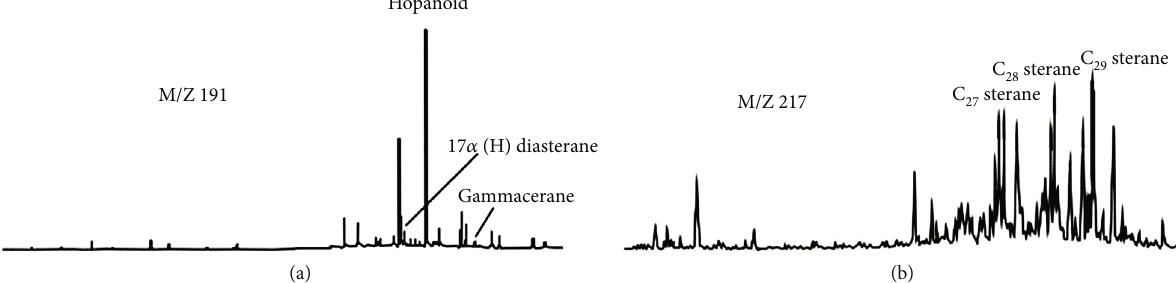
Figure 4: Comparison graph of biomarker terpene and sterane hydrocarbon of crude oil of C8 of C